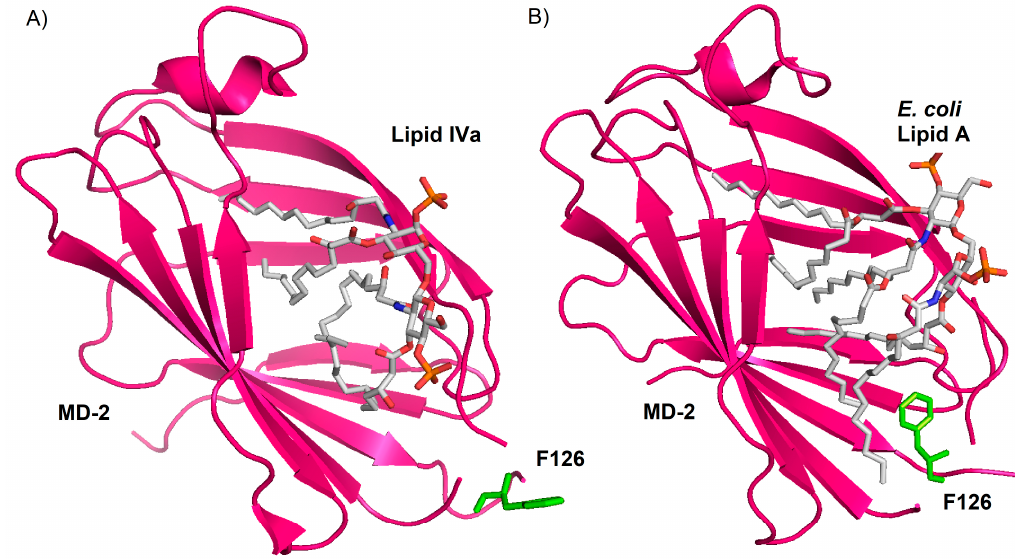
Figure 5. ( A ) Cristal structure of human MD-2 with Lipid IVa (PDBID: 2E59); ( B ) Cristal structure of human MD-2 with E. coli Lipid A (PDBID: 3FXI). Human MD-2 is displayed in purple as ribbon, F126 are displayed in green as sticks and Lipid IVa and Lipid A are displayed according to the color of the atoms as sticks.